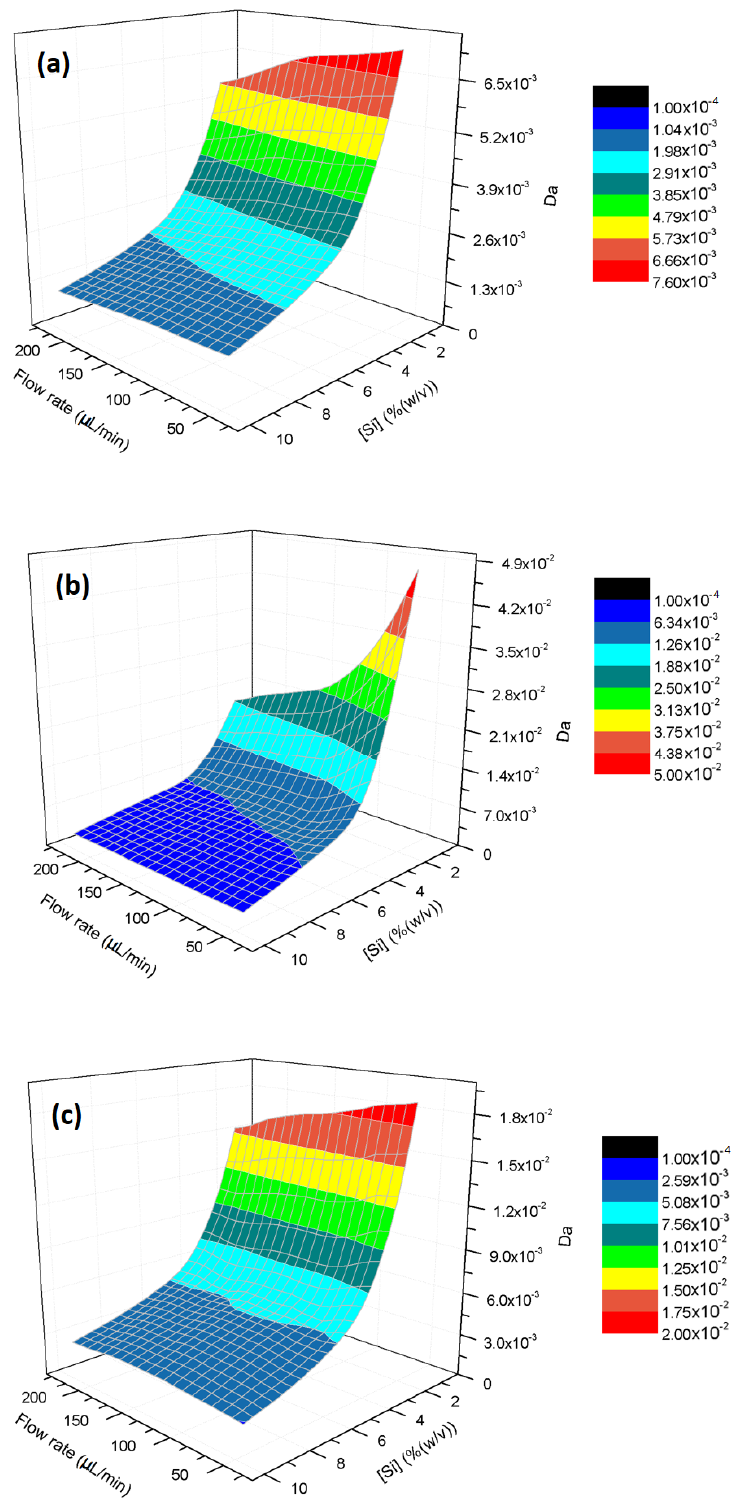
Figure 7. Damköhler numbers calculated for the operation of the microchannel reactor at flow rates and substrate concentrations in the range of 20.8–219.0 µL·min − 1 and 2.0%–10.0% ( w / v ), respectively. Substrate values considered in the calculation: ( a ) substrate concentration at the inlet; ( b ) substrate concentration at the outlet; and ( c ) average substrate concentration.